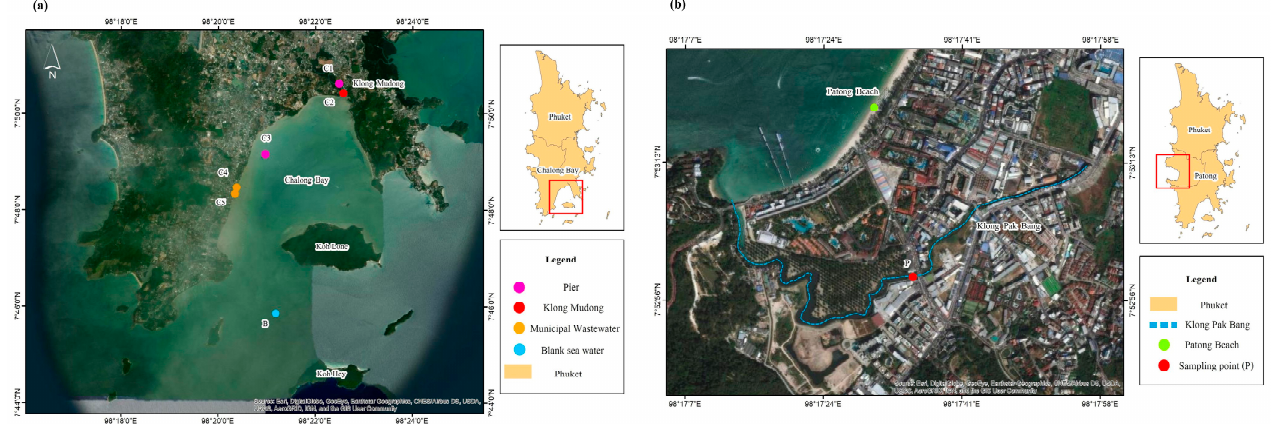
Figure 7. Sampling points for water samples at ( a ) Chalong Bay, and ( b ) Pak Bang Canal in Patong, Phuket, Thailand.